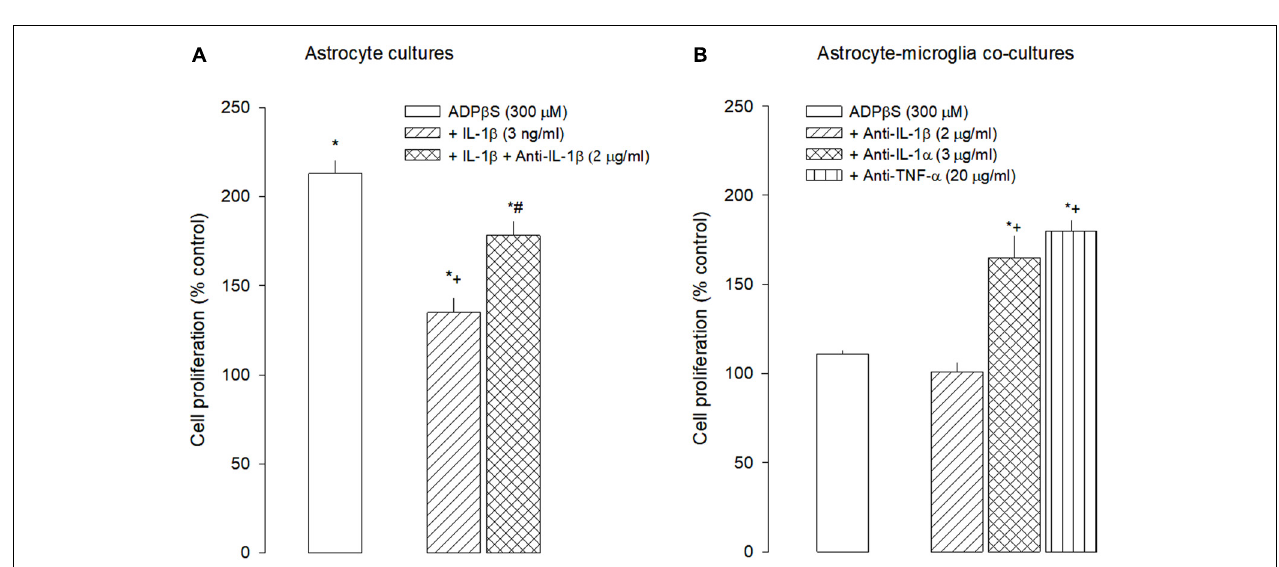
FIGURE 5 | Cellular distribution and localization of P2Y 13 receptors in astrocyte-microglia co-cultures. Astrocytes were double labeled with (A) mouse anti-GFAP (Alexa Fluor 488, green) and with (B) rabbit anti-P2Y 13 receptor (Alexa Fluor 594, red). Microglia were double labeled with (D) mouse anti-CD11b (Alexa Fluor 488, green) and with (E) rabbit anti-P2Y 13 receptor (Alexa Fluor 594, red). Nuclei were labeled with Hoechst 33258 (blue). P2Y 13 receptors (red) co-localize with astrocytes (C) but mainly with microglia (F) . Scale bar: 100 µ m.